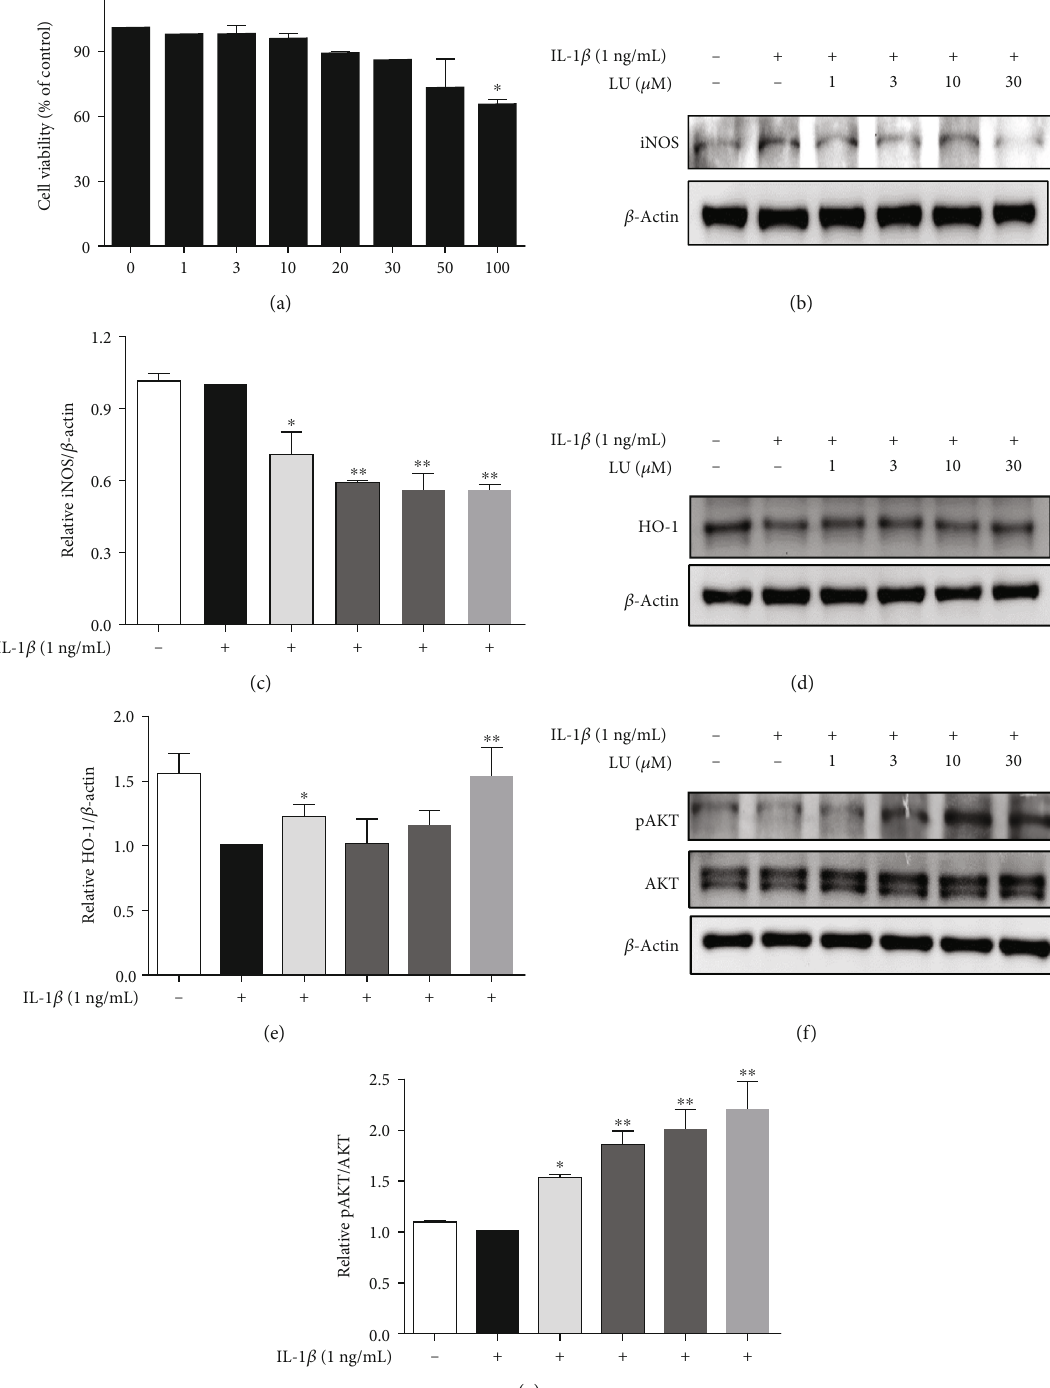
Figure 2: Luteolin inhibited in fl ammatory mediator expression and increased anti-in fl ammatory protein HO-1 expression in IL-1 β - stimulated ARPE19 cells. (a) Cell viability of ARPE19 cells treated with various luteolin (LU) concentrations (0 – 100 μ M). Cells were pretreated with luteolin for 1 h, then stimulated with IL-1 β (1 ng/mL) for 24 h. (b) Cells were pretreated with di ff erent LU doses and then incubated with IL-1 β (1 ng/mL) for 30 min or 24h. Western blots show iNOS protein expression. (c) The fold-change in iNOS protein expression was measured relative to β -actin expression. (d) Western blots show HO-1 protein expression. (e) The fold-change in HO-1 protein expression was measured relative to β -actin expression. (f) Western blots show phosphorylated AKT protein expression. (g) The fold-change in pAKT protein expression was measured relative to AKT expression. Data represent the mean ± SD . ∗ p < 0 : 05 , ∗∗ p < 0 : 01 , compared to ARPE-19 cells stimulated with IL-1 β